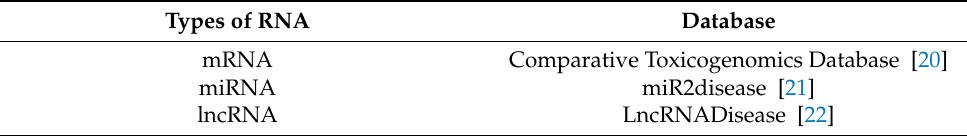
Table 2. Colon cancer-related RNAs and database.